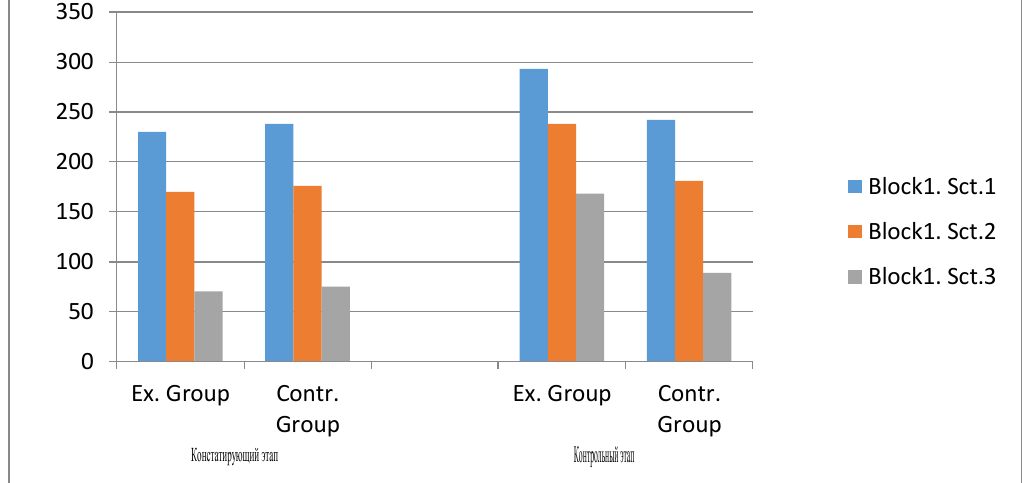
Figure 5. Test results of students concerning question of Block 1 at ascertaining and control stage of